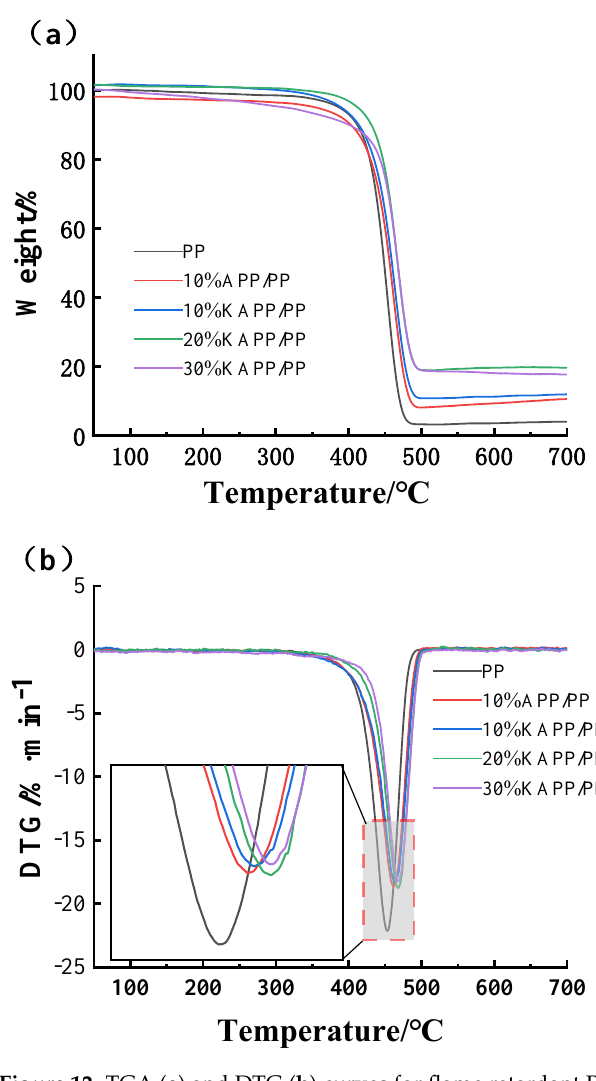
Table 8. Thermal weight loss data for flame retardant PP under nitrogen atmosphere.